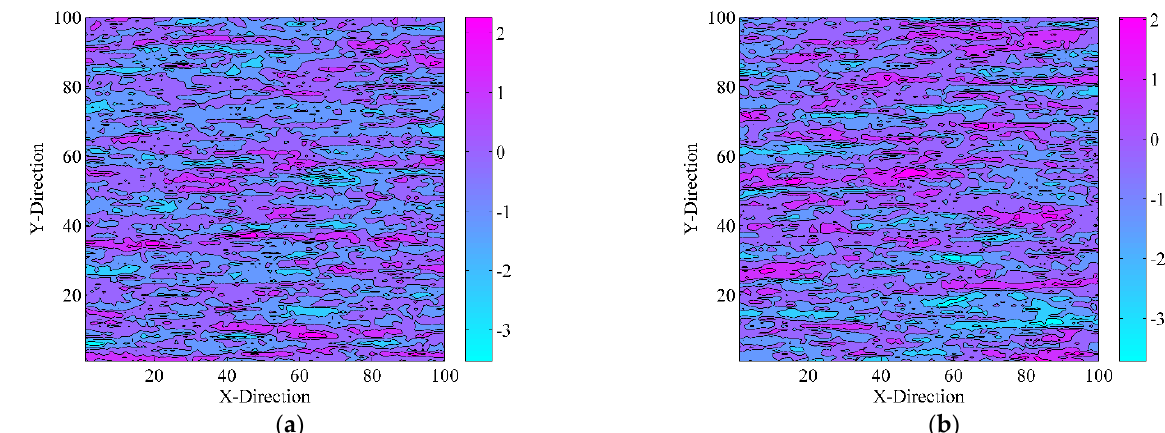
Figure 1. Independent standard normal and transversely anisotropic random field H IAG . ( a ) Random field of u . ( b ) Random field of v. field of u . ( b ) Random field of v